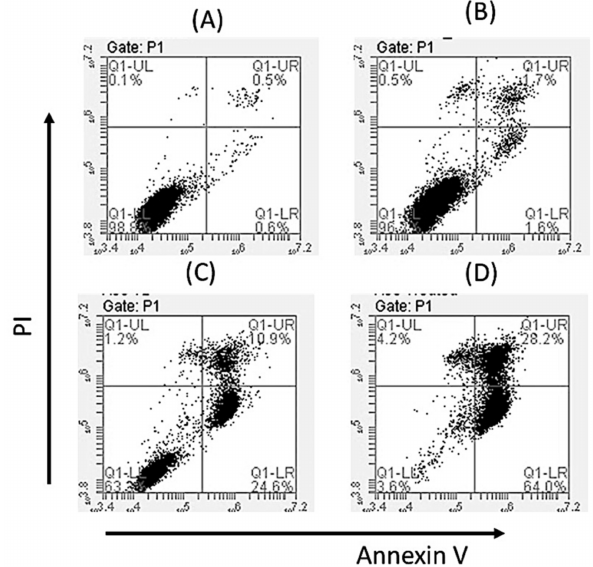
Figure 6. Oroxyquinone sensitizes PC3 cells to Annexin V: PC3 cells treated with PBS ( A ), or 30 µ M ( B ), 60 µ M ( C ) and 120 µ M ( D ) oroxyquinone were stained with Annexin V (FITC) and PI to determine apoptosis. An increase in the number of annexin V-positive cells was observed from 24.6% to 64.0% of the total cells with an increased dose of